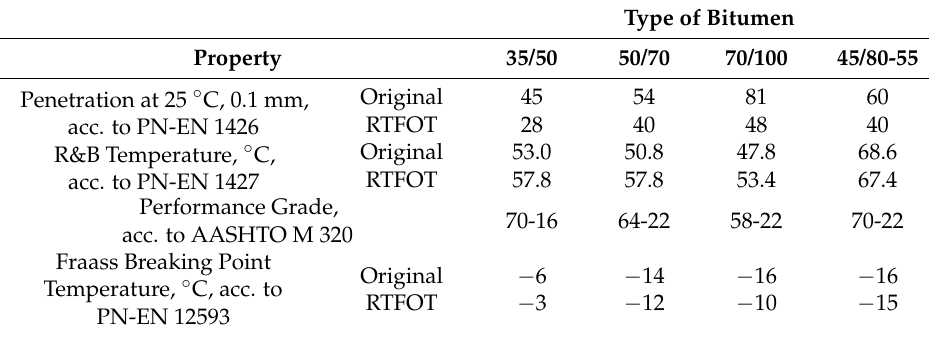
Table 1. Properties of